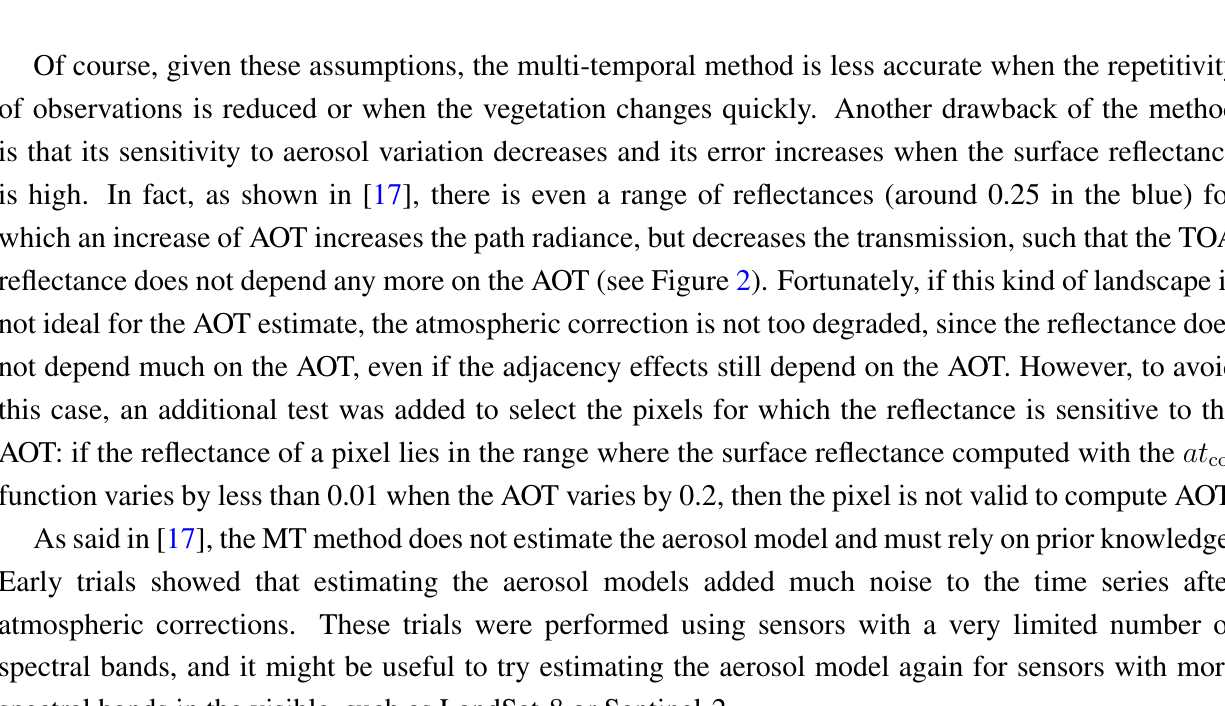
Figure 3. Schematic of the multi-temporal (MT) cost function. The MT method searches the AOT of dates D and D that minimizes the squared differences of surface reflectance r from dates D and D and the squared differences with the result of a previous iteration of r the